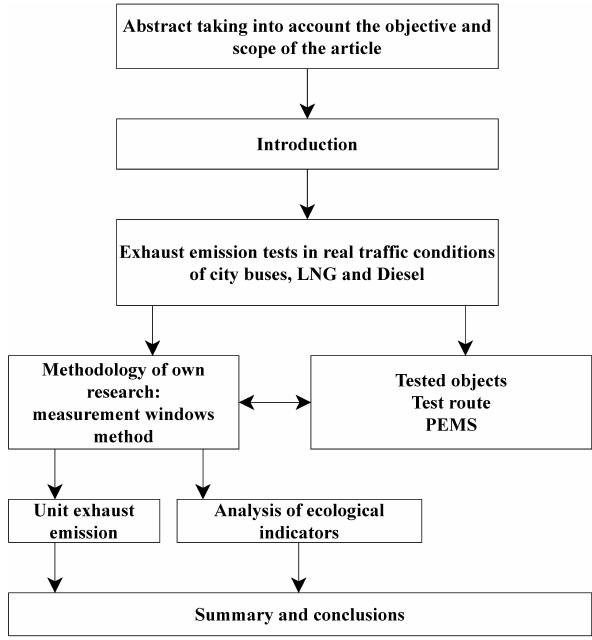
Figure 1: Structure of research.